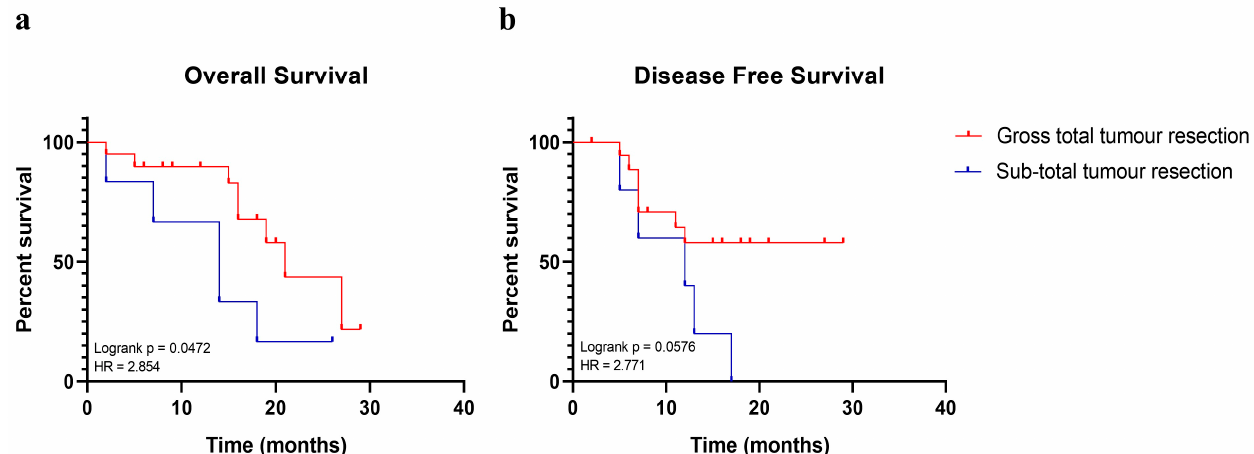
Figure 1. Kaplan–Meier curves performed on patients enrolled in the study. Survival analysis displays the estimated survival of patients who either received a gross total tumour resection during surgery (in red) or who received a sub-total one (in blue). Timing is expressed in months. ( a ) Shows the effects of the gross total tumour resection on the overall survival. ( b ) Shows the effects of the gross total tumour resection on the disease-free survival. Log-rank p values and hazard ratio (HR) are reported.